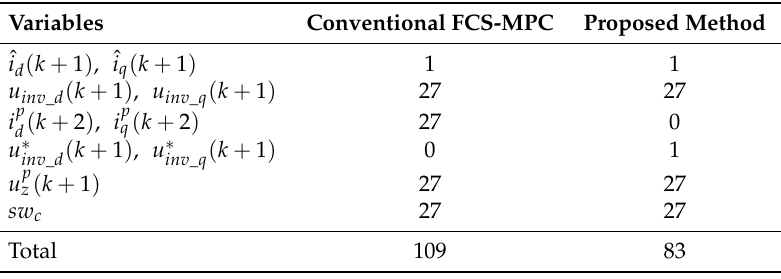
Figure 5. Block diagram of the proposed control scheme. Table 2. Comparison of computational cost between two